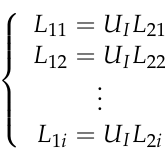
Figure 3. The processing flow of the reconstruction module.